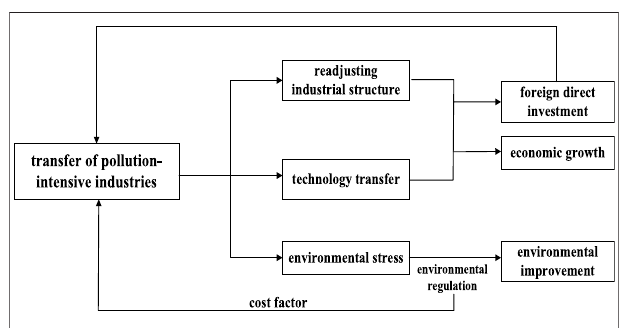
FIGURE 1 | Analysis of the transfer mechanism of pollution-intensive